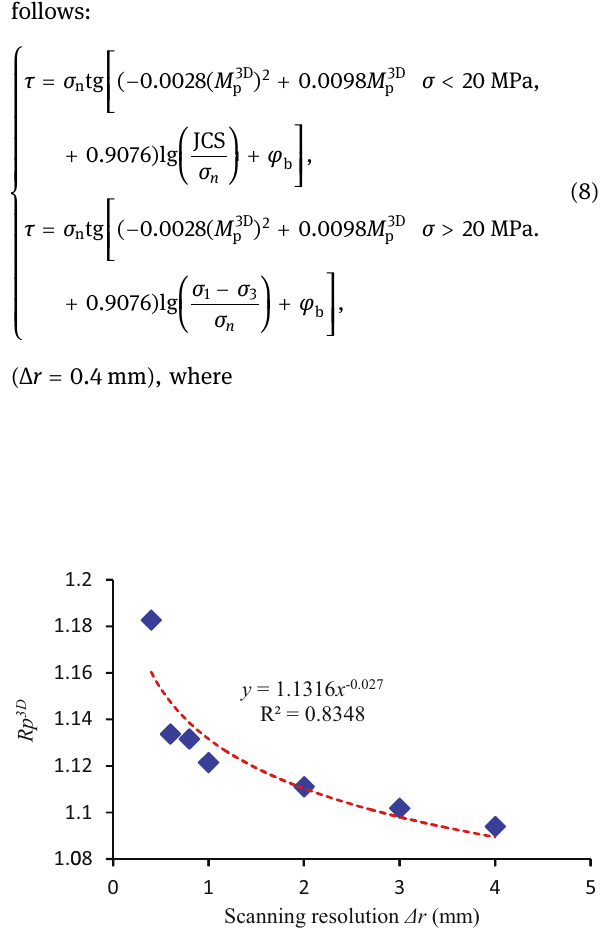
Figure 8: Relation curve of Δ r with R p3D